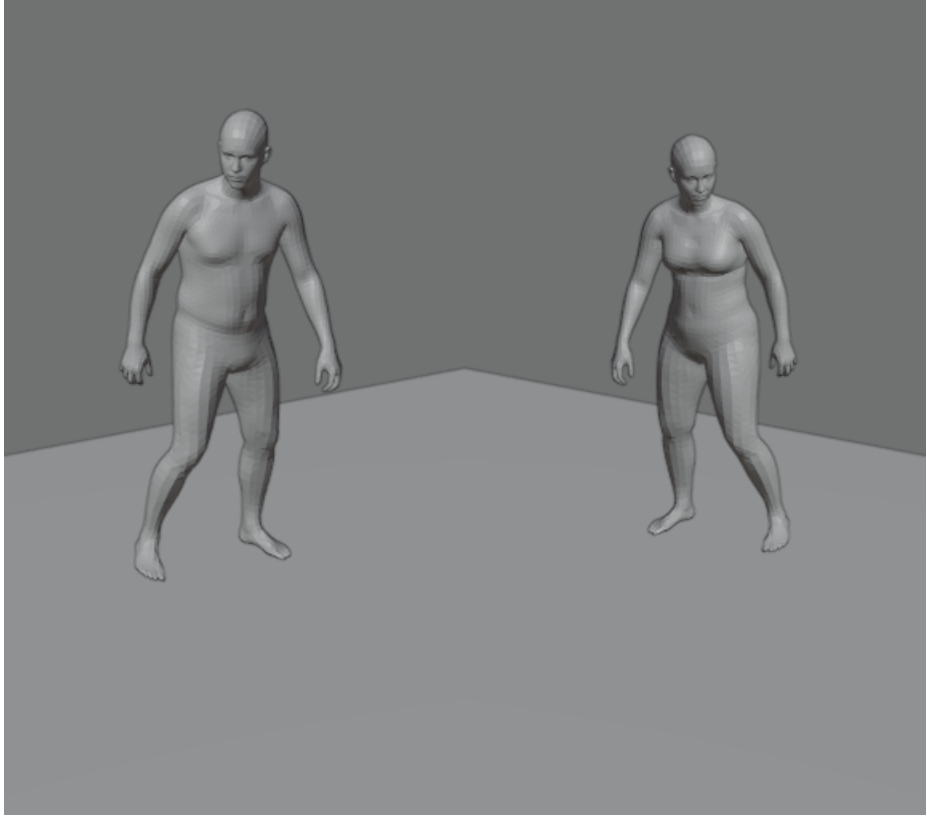
Figure 2. An example MoVi dataset motion capture pose applied to models provided by AMASS. The same pose is applied to female and male body type.